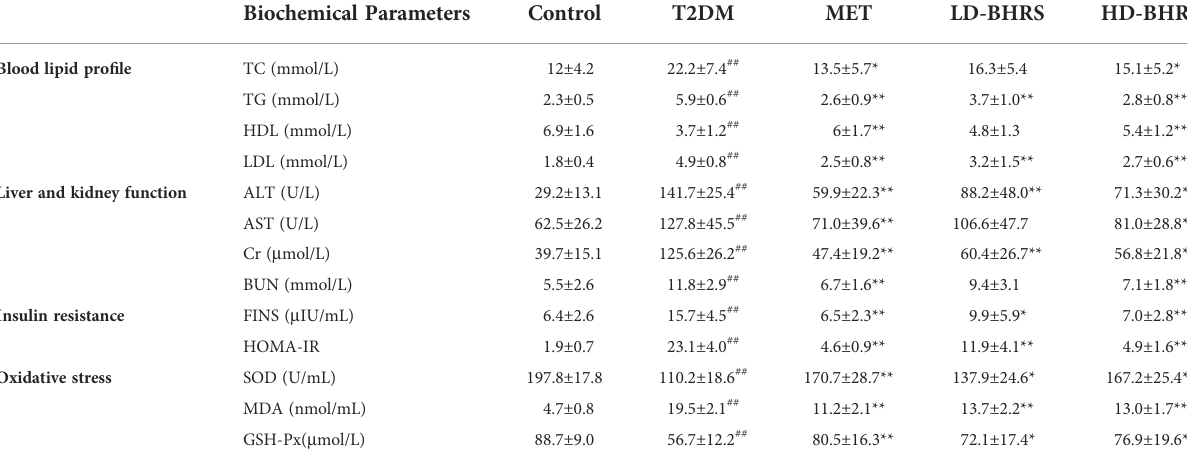
TABLE 1 Changes in physiological indices, oxidative stress factors, and insulin resistance after BHRS treatment. Biochemical